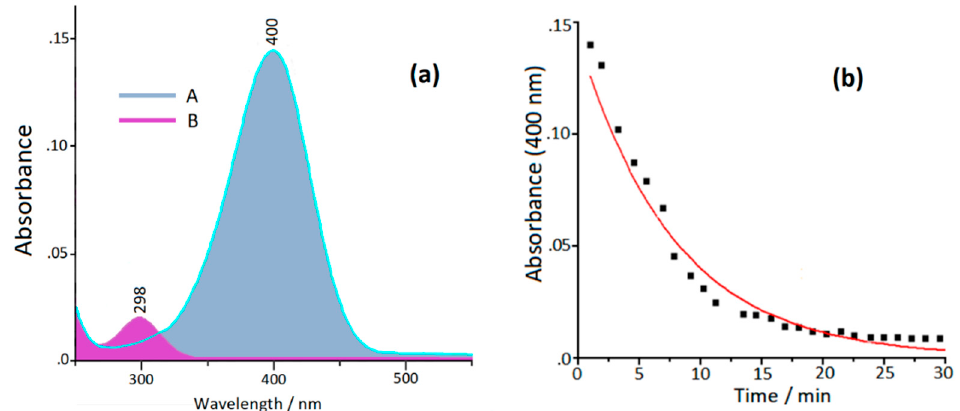
Figure 7. ( a ) UV-vis absorption spectra of the PNP / NaBH 4 solution before (A) and after 30 min (B) from the addition of the PdO colloidal sample [optical path length (OPL) = 1 cm]; ( b ) time evolution of the 400 nm extinction band.